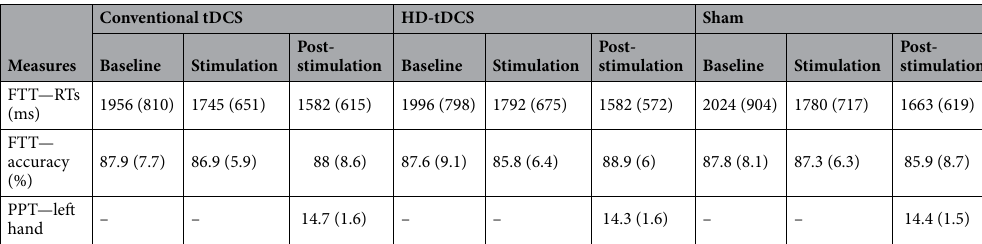
Table 1. Mean and standard deviation ( SD ) of performance measures on the Finger Tapping Task and the Purdue Pegboard Test for Conventional tDCS, HD-tDCS, and sham. RTs response times, FTT Finger Tapping Task, PPT Purdue Pegboard